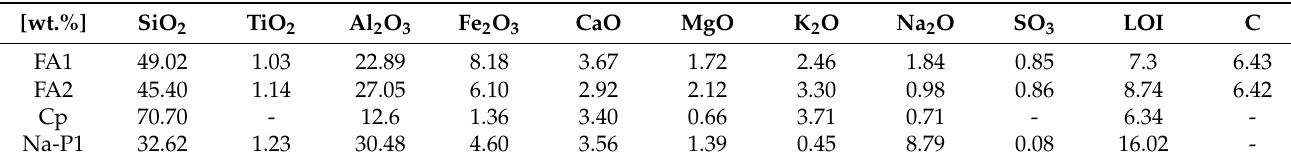
Table 1. Chemical composition of coal fly ash (CFA1, CFA2), Clinoptilolite-Cp, and synthetic zeolite Na-P1.